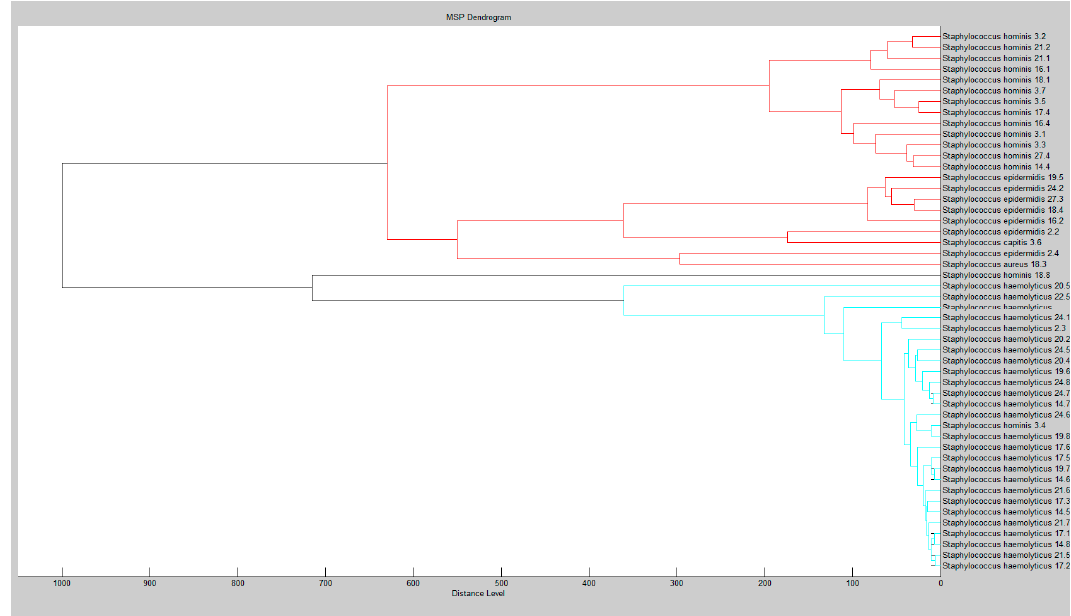
Figure 1. Dendogram of isolated Staphylococcus spp. from human semen constructed with a MALDI- Figure1. Dendogramofisolated Staphylococcus spp. fromhumansemenconstructedwithaMALDI-TOF TOF MS Biotyper. MS Biotyper.